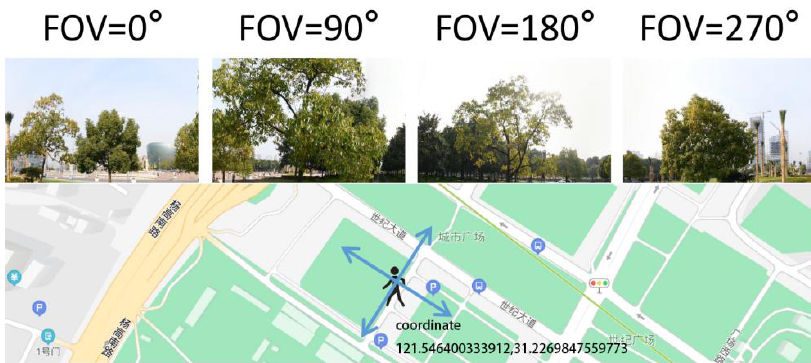
Figure 3. Four street-view images from four directions at one sampling point.